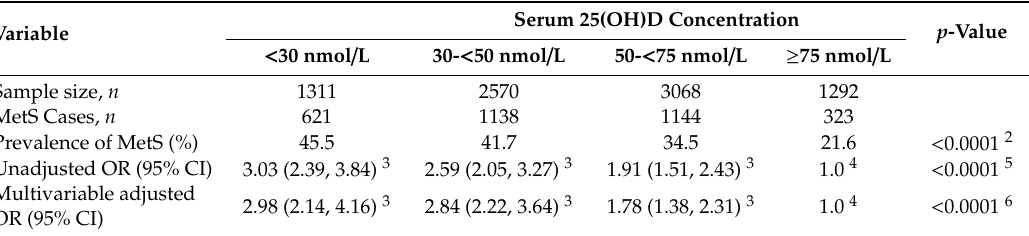
Table 2. Multivariable adjusted odds ratio (OR) and 95% confidence interval (CI) for